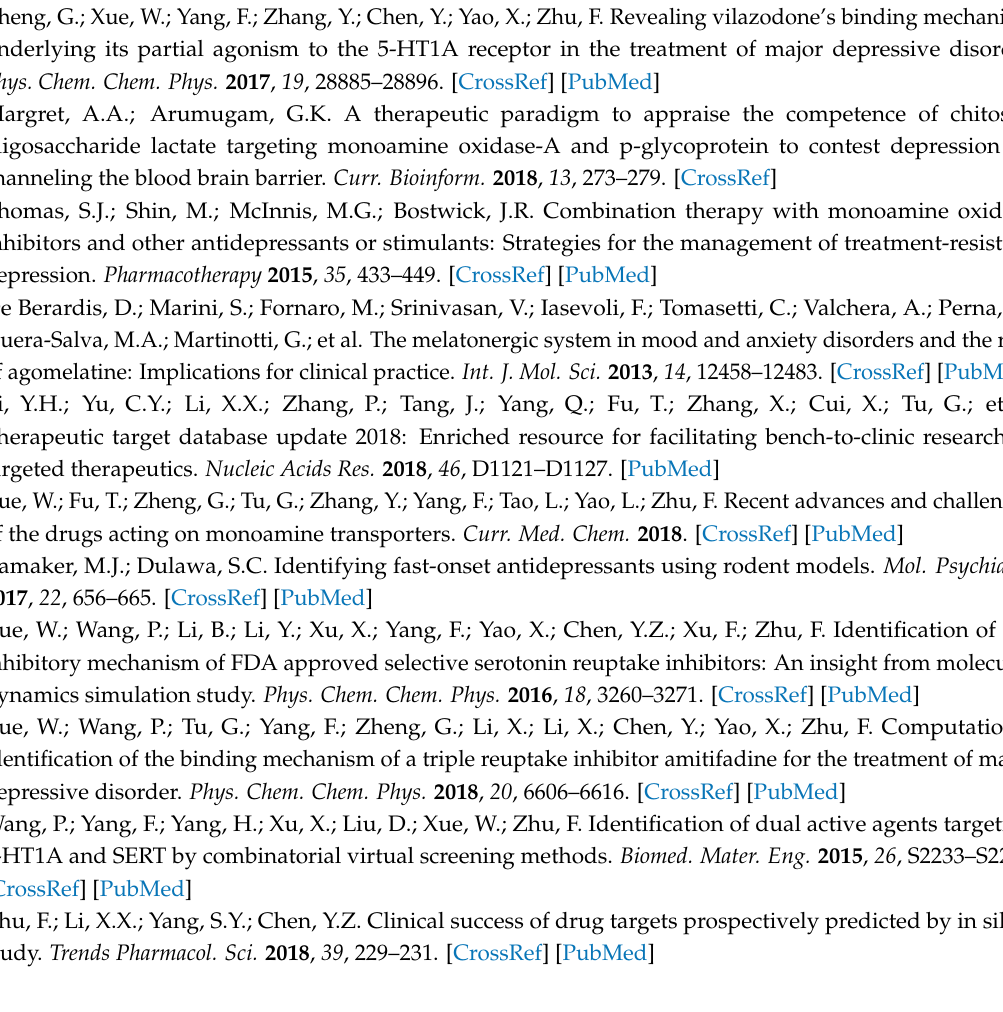
1JKS and 5AV4, Figure S21: The monitored RMSD of the all atoms with respect to the initial structure during